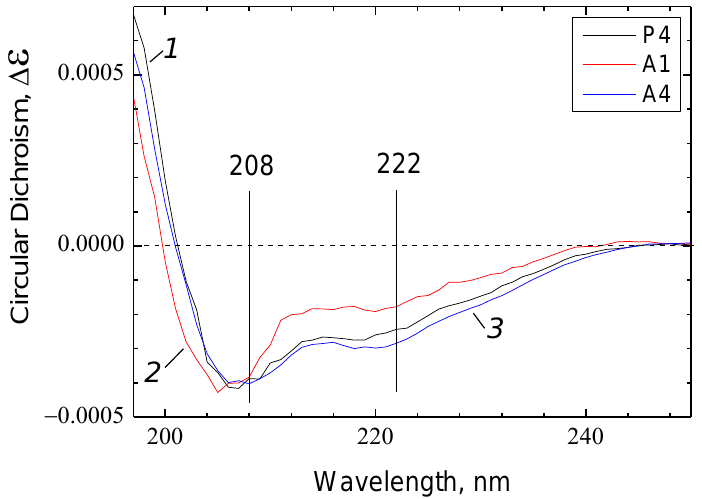
Figure 7. The circular dichroism spectra of the peptides. The peptides P4, A1 and A4 (spectra 1–3, respectively) were diluted in BM medium up to 0.5 mg of protein/mL (c.a. 170 µ M of a peptide). The local minima at 208 and 222 nm characteristic of the α -helical structure are indicated.